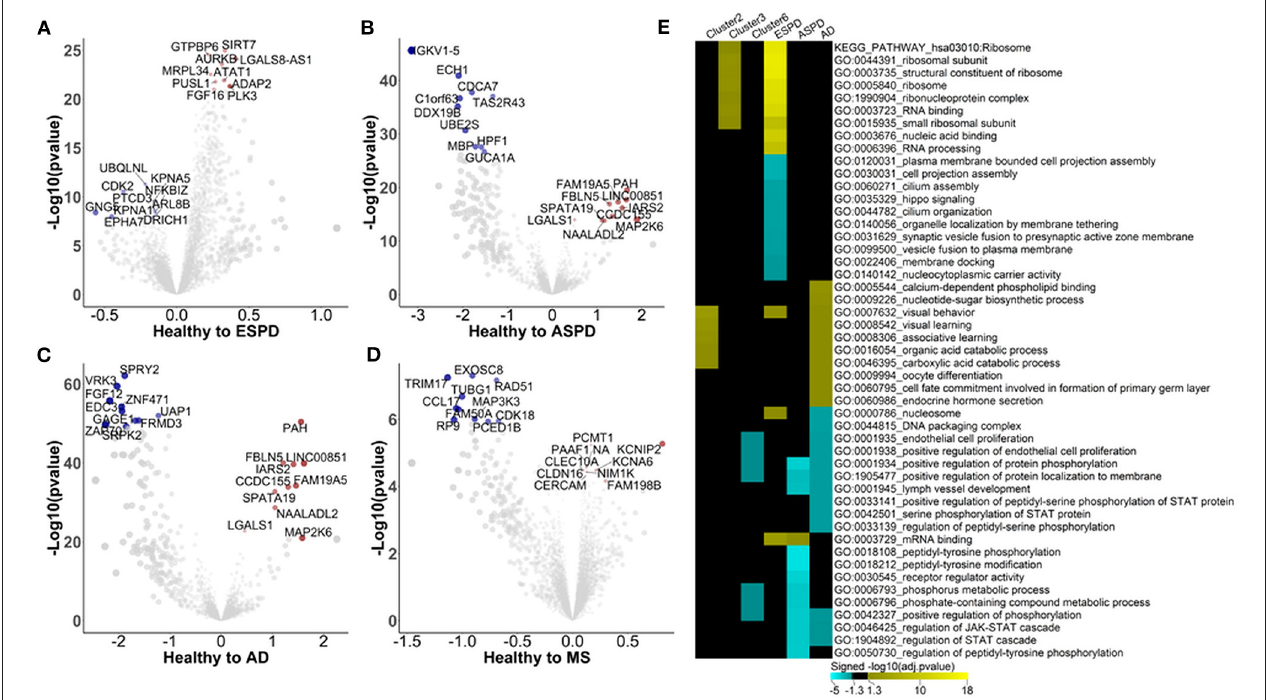
FIGURE 3 | Autoimmunomic signatures of neurodegnerative diseases identified by linear modeling. In total, serum levels of IgG autoantibodies against 9,256 human antigens in 103 patients with ESPD, 24 patients with ASPD, 46 patients with AD, and 30 patients with MS as well as their corresponding age- and gender matched healthy controls were analyzed using linear modeling. Volcano plots representing changes within the autoimmunome in ESPD (A) , ASPD (B) , AD (C), and MS (D) . Dot sizes are proportional to the product of –log10( p -value) and disease effect (beta of the linear model). (E) Visualization of pathways significantly enriched for aging- and disease-associated autoantibodies identified by linear modeling. Autoantibodies upregulated and downregulated were analyzed separately. Top 10 significantly enriched gene ontology terms per condition per disease are represented, and aging related clusters are used as